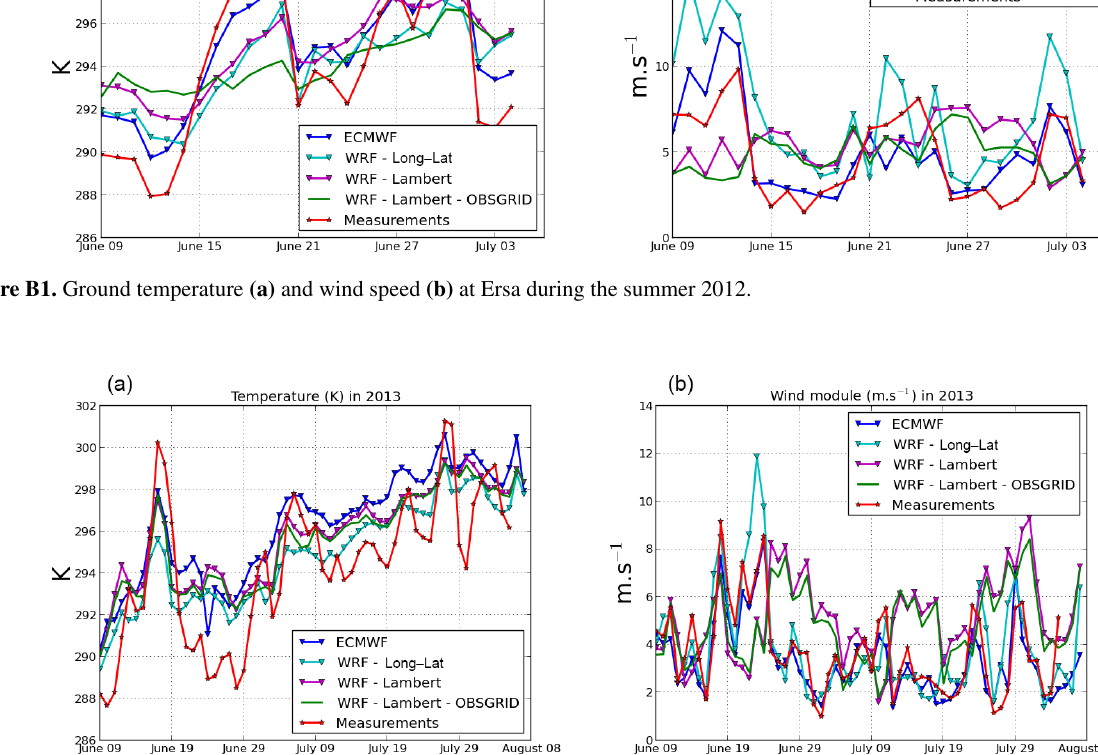
Figure B2. Ground temperature (a) and wind speed (b) at Ersa during the summer